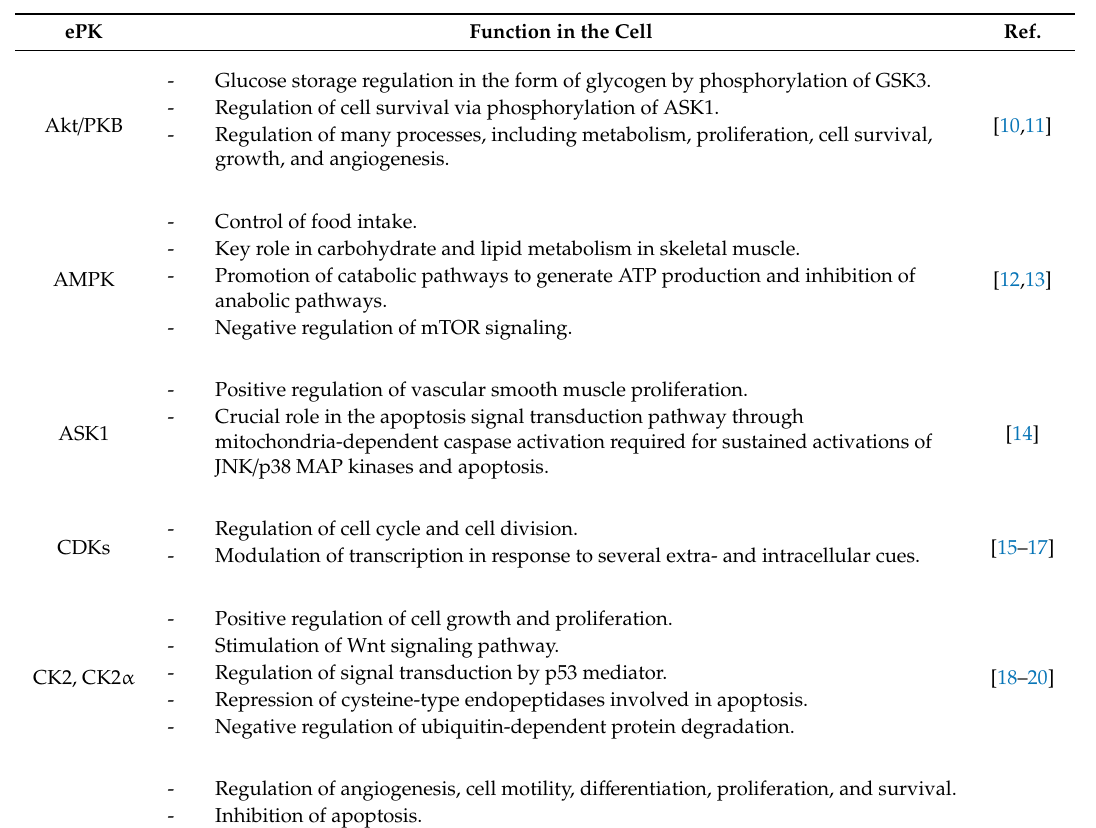
Table 1. Selected ePKs and their cellular